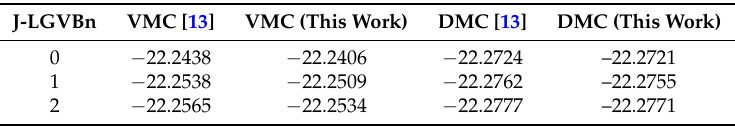
Table 1. Comparison between variational Monte Carlo (VMC) and diffusion Monte Carlo (DMC) electronic energies (Hartree) of hydrazine computed with the full atomic basis set [13] and with the reduced basis set obtained from KS orbital decomposition presented in this work. The wave function form is indicated by the level n of the Jastrow-Linear Generalized Valence Bond (J-LGVBn) theory [13]. Statistical error is about 0.0001 Hartree.